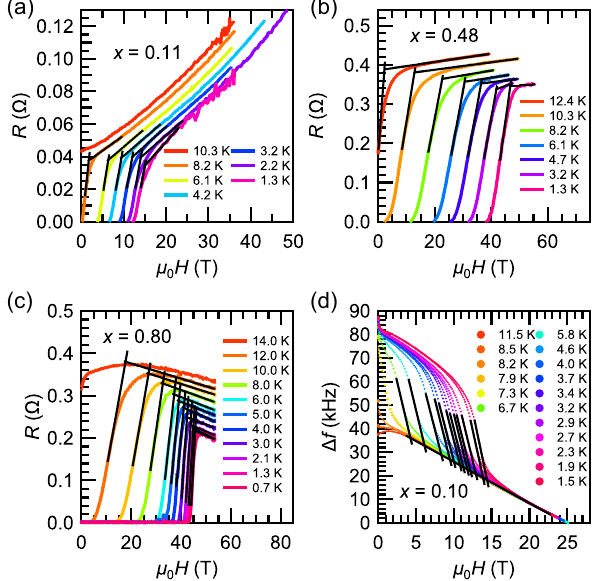
FIG. 1. Determination of H resistance measured at several temperatures for x ¼ 0 . 11 (a), 0.48 (b), and 0.80 (c). The upper critical field H intersection of the two black lines. (d) Magnetic field dependence of the change in the resonant frequency Δ f observed in the TDO measurement for x ¼ 0 . 10 . H where two black lines are crossing.